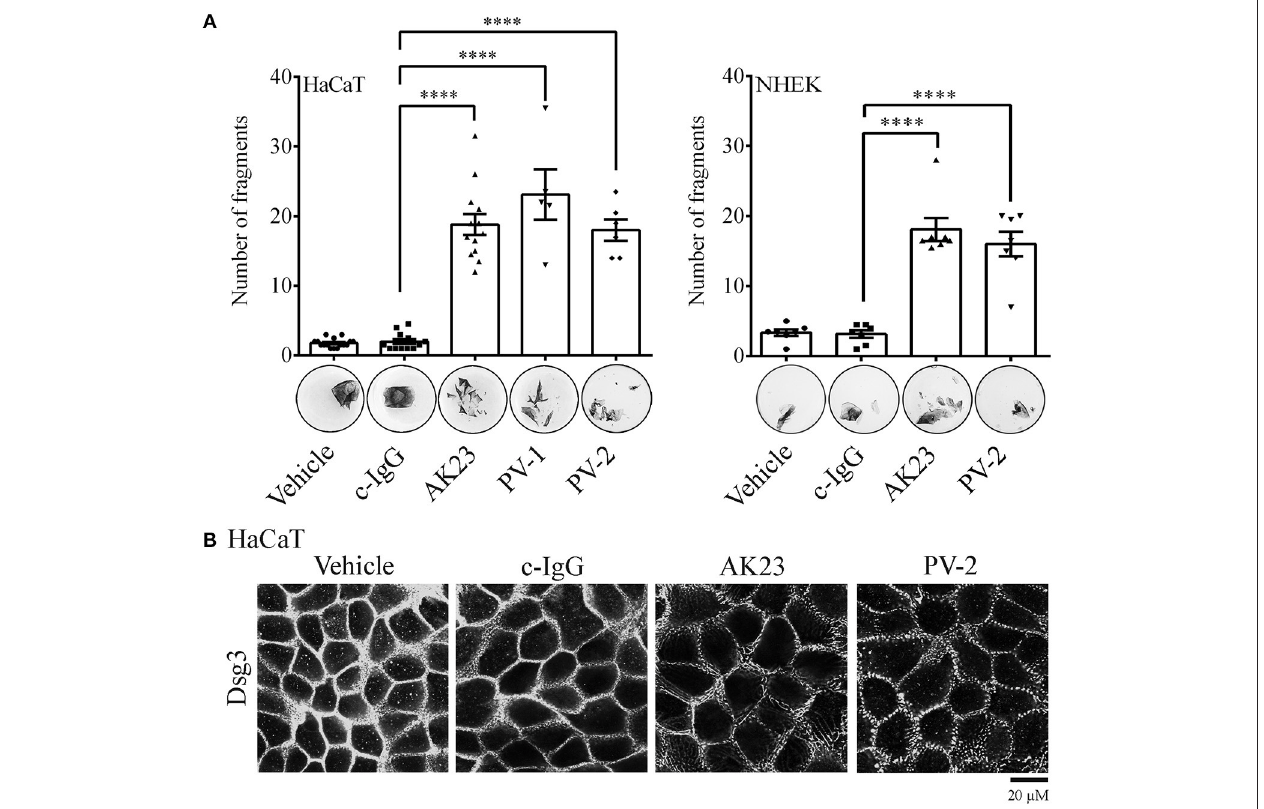
FIGURE 1 | Pemphigus autoantibody application induces loss of keratinocyte cohesion and fragmentation of Dsg3 immunostaining. (A) Dispase-based dissociation assay in human HaCaT and NHEK keratinocytes after treatment with pemphigus autoantibodies. Besides PBS-treated monolayers (Vehicle), cells exposed to c-IgG were also used as a control. Representative images of cell sheets pre-stained with MTT and subjected to defined mechanical stress ( n ≥ 6, One-way ANOVA, **** p ≤ 0.0001 vs. c-IgG). (B) Dsg3 immunostaining in response to pathogenic autoantibodies (PV-IgG and monoclonal autoantibody AK23, targeting Dsg3). Representative images of n ≥ 4 (Scale bar: 20 µ